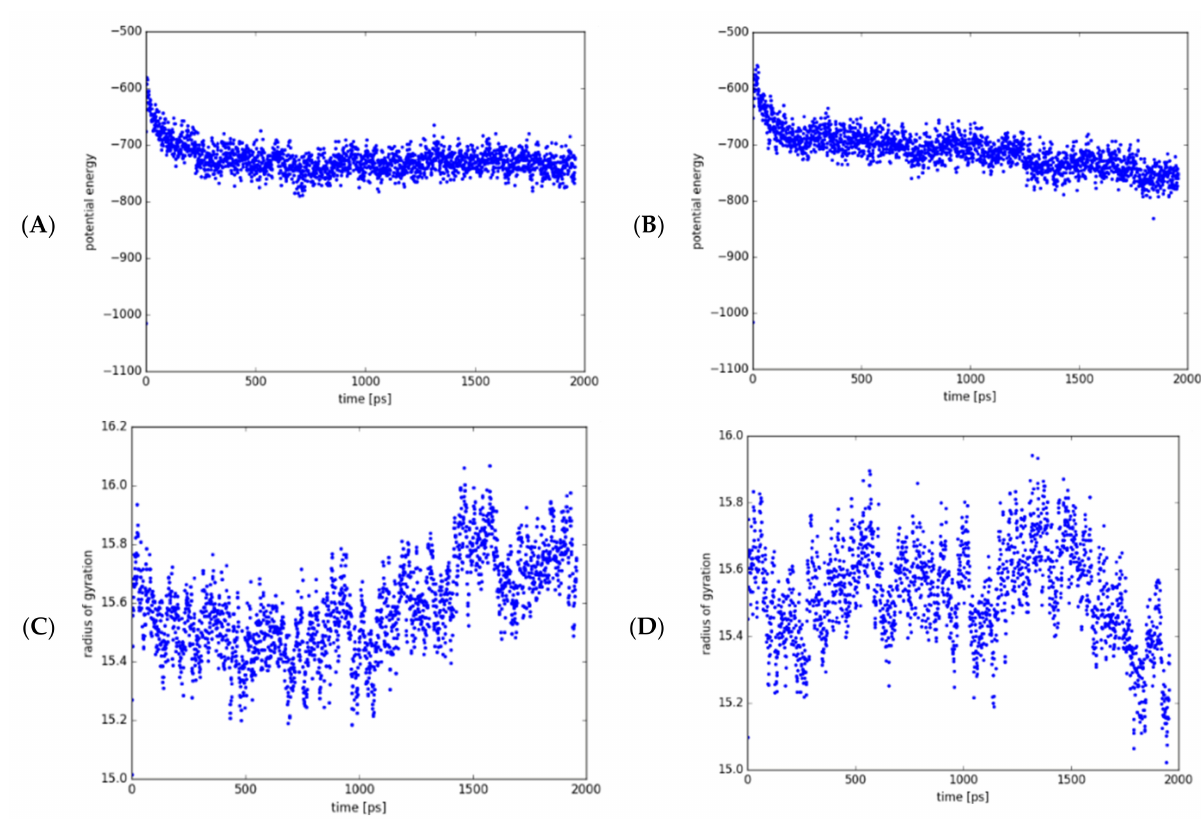
Figure 3. MD analysis of the wild-type (WT, L101) and mutant (MU, F101) systems ( Mt GidB) in a 2000-ps simulation. Plots of potential energy (Kcal/mol) for WT ( A ) and MU ( B ). Plots of the radius of gyration (Å) for WT ( C ) and MU ( D ).